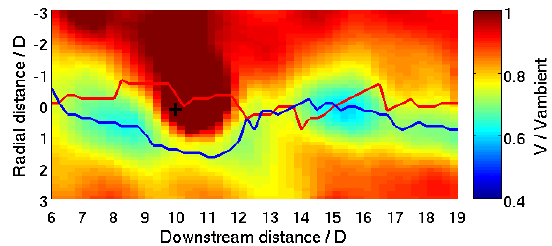
Figure 9. Normalized horizontal wind speed downstream of wind turbine located at 0 D obtained from TS-X measurements (color coded). The centre of the wake track is marked for the lidar measurement (red line) and the corresponding wake track from the TS-X measurement (blue line). The position of a second turbine is marked (+). Both axes are normalized with the rotor diameter D of the wake generating